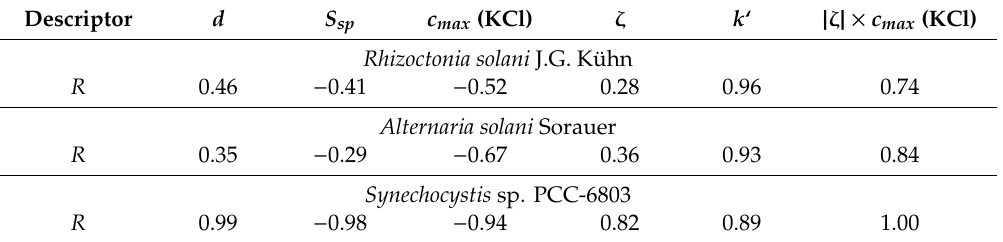
Table 9. Pearson linear correlation coe ffi cient ( r ) values for silver NP dispersion descriptors and their toxicity against R. solani and A. solani log 10 (EC 50 ) and Synechocystis sp. log 10